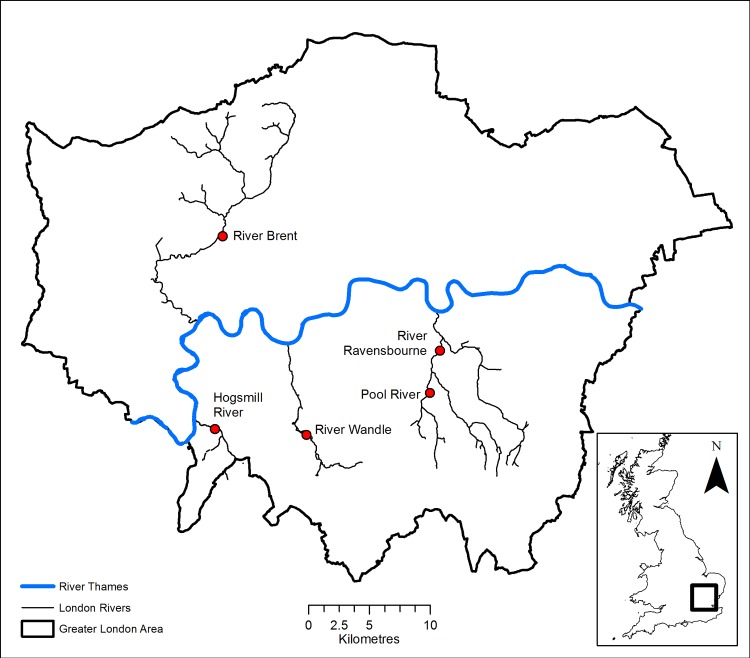
Study sites situated within Greater London, UK.Dots highlight the locations of each of the five study rivers, Ravensbourne, Pool, Wandle, Hogsmill and Brent.